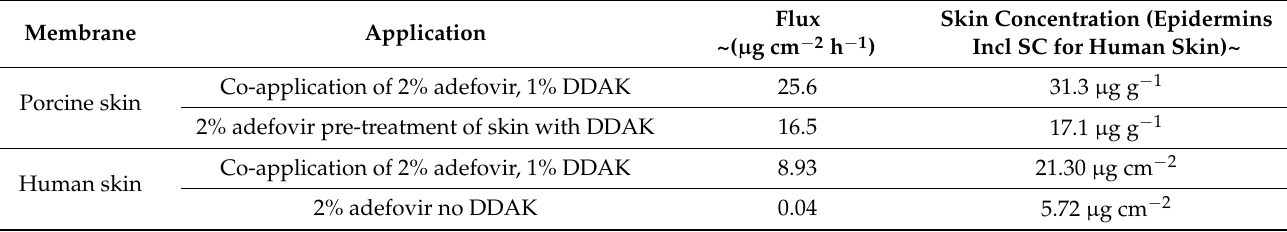
Table 18. Flux and skin concentration of adefovir after use of DDAK (for human skin experiments n ≥ 3 ≤ 4, except for 2% adefovir samples where n = 12, for porcine skin experiments n = 4, except for co-application samples where n = 12, values represent the mean). Adapted from [49], Elsevier, 2008.